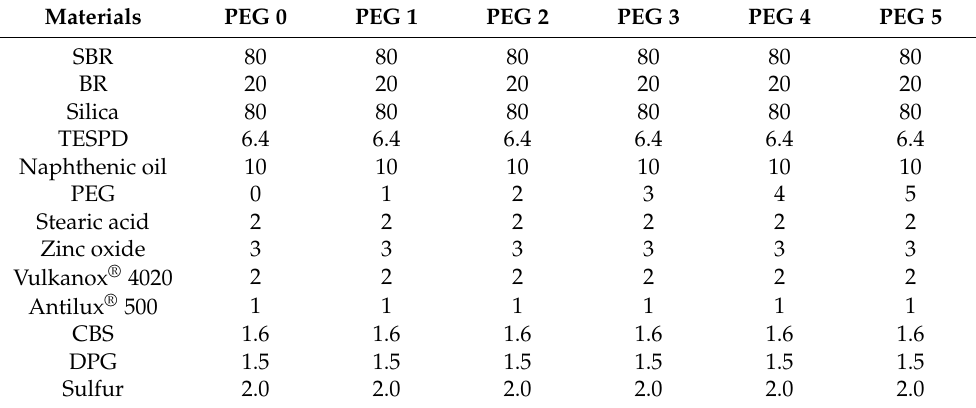
Table 2. Formulation for the composites in phr (parts in weight per 100g